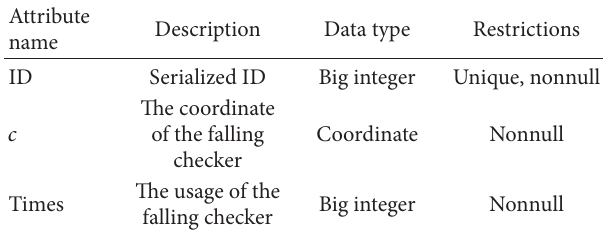
Table 2: Attributes of the PiecesStateSequence .